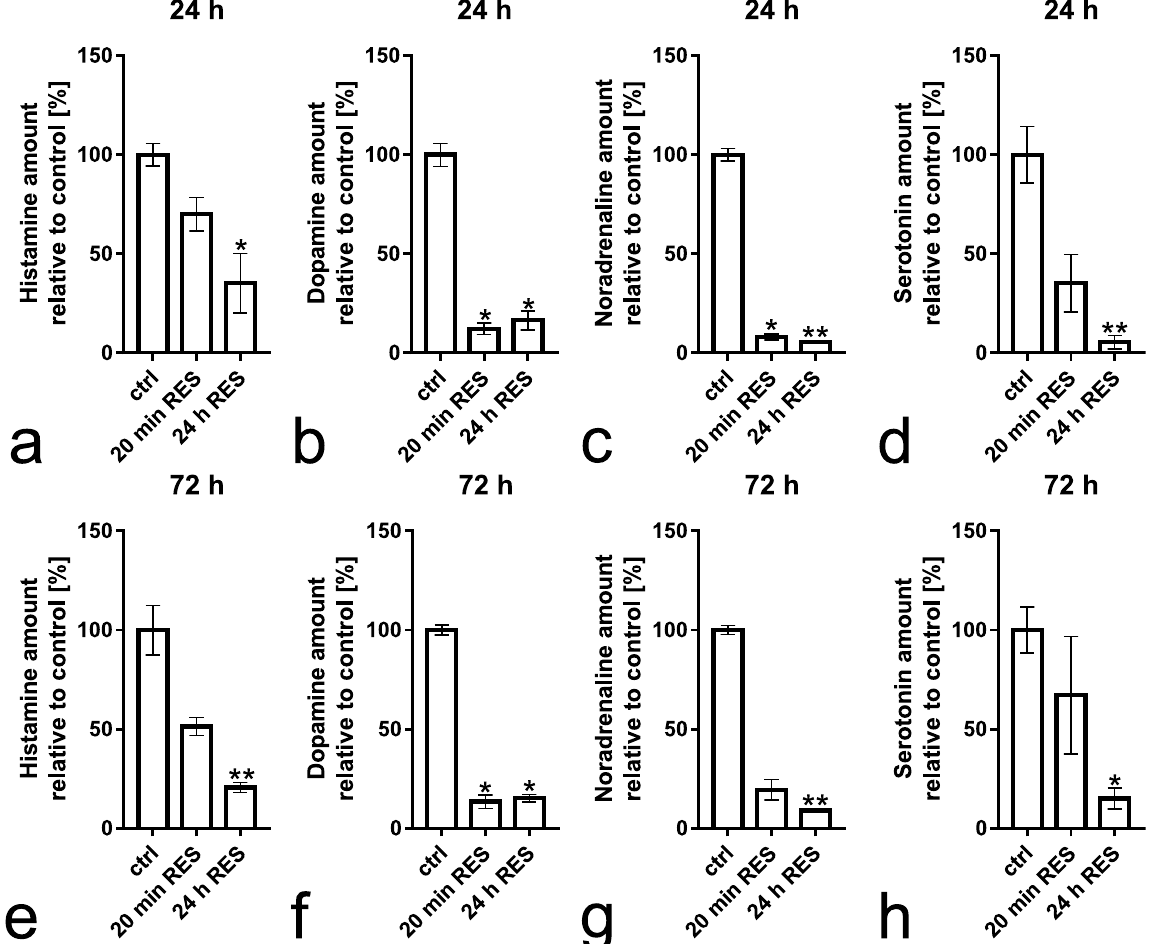
Figure 7. Monoamine levels measured by HPLC at 24 h and 72 h after the start of the reserpine treatment. At both time points, histamine levels were significantly decreased in comparison to controls in the 24 h treated group ( a , e ). The 20 min treated group follows a similar trend, however, this observation did not reach statistical significance. Dopamine levels were significantly decreased at both time points in both reserpine treated groups ( b , f ). Noradrenaline levels were decreased at both time points in the group treated with reserpine for 24 h ( c , g ). In the group treated with reserpine for 20 min, noradrenaline levels were significantly decreased at 24 h after treatment and followed a similar trend at 72 h after treatment, although the difference at this time point was not statistically significant ( c , g , post-test p = 0.0771 in g ). Serotonin levels were significantly decreased in the 24 h group at both time points ( d , h ). Data presented as mean ± SEM. n = 4–5 per group. Statistical analyses were done using Kruskal-Wallis test, followed by Dunn’s multiple comparison test. * p < 0.05, ** p < 0.01 according to the multiple comparison test, in comparison to the control